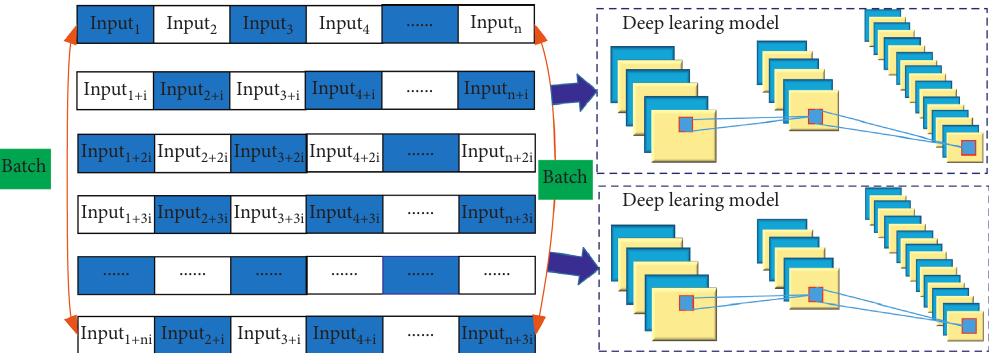
Figure 5: Model training input after batch division.